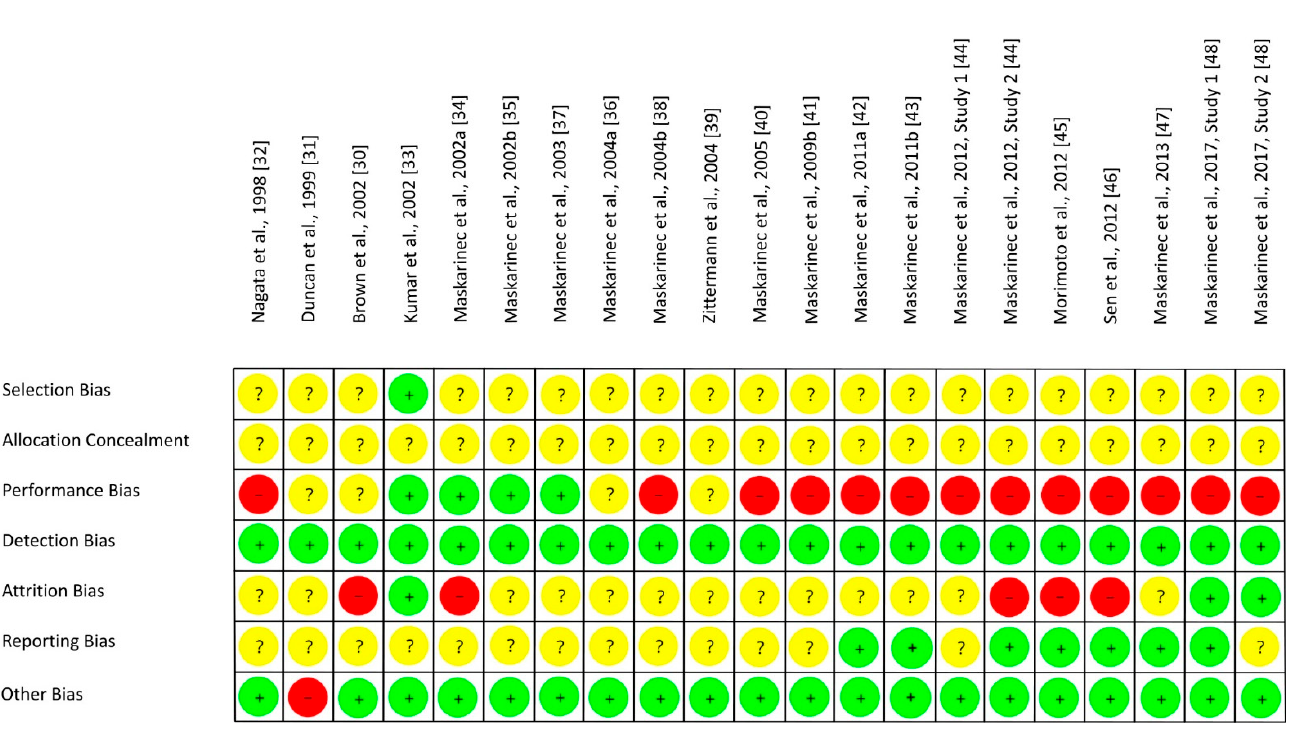
Figure 2. Risk of bias for studies with premenopausal women. Green (+), low risk of bias; yellow (?), unclear risk of bias; red ( − ), high risk of bias.